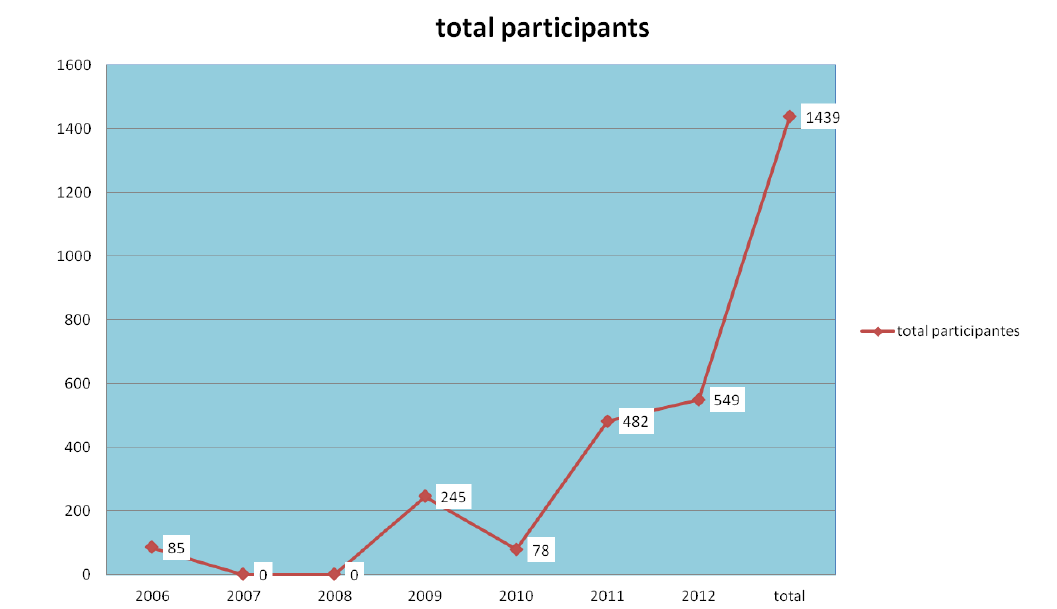
Figure 10. Number of techniques used by the Health